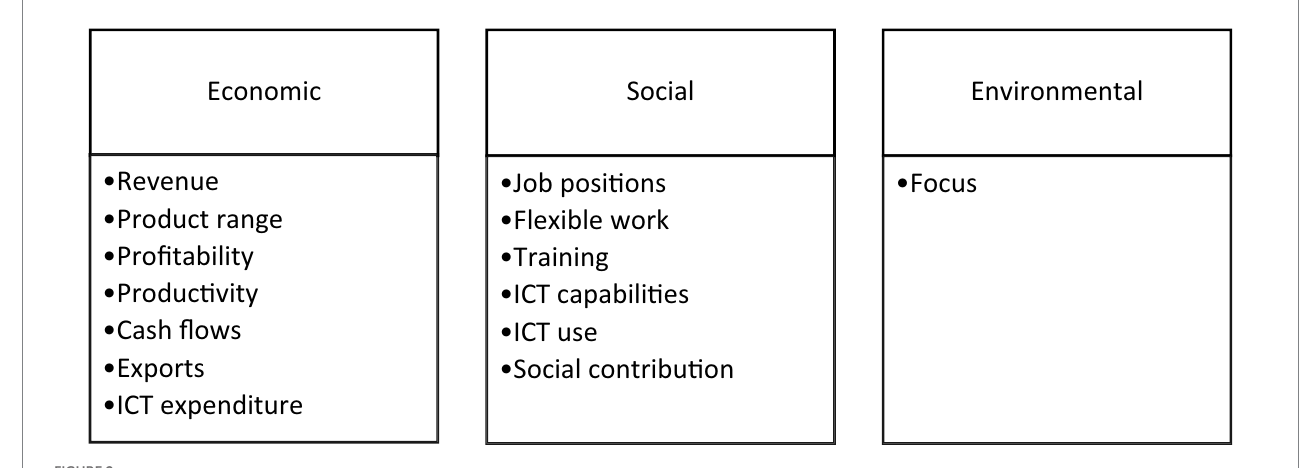
FIGURE 2 Performance dimensions and performance